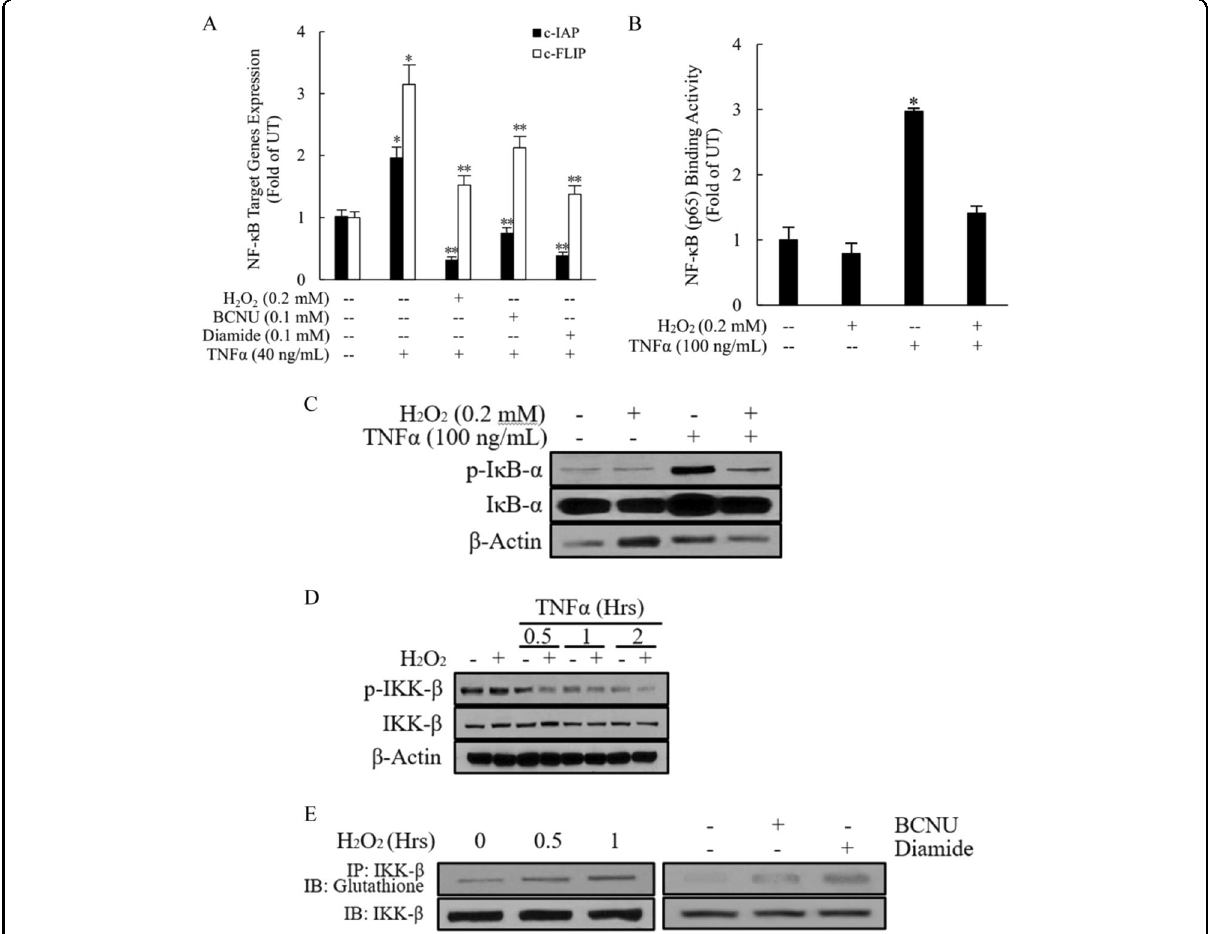
Fig. 6 GSSG suppresses TNF α -stimulated NF- κ B transactivation via induction of IKK- β glutathionylation. a H 2 O 2 , BCNU, or diamide pretreatment suppressed NF- κ B-mediated gene expression after TNF α stimulation. HepG2 cells were pretreated with H 2 O 2 , BCNU or diamide for 2 h before TNF α (40 ng/mL) addition. Total RNA was isolated, and NF- κ B-targeted gene expression was determined by real-time RT-PCR. All values are expressed as the mean ± SD from three or more independent studies. * p < 0.05, ** p < 0.01 versus TNF α -treated cells. b H 2 O 2 pretreatment suppresses TNF α -induced nuclear p65/DNA-binding activity. HepG2 cells were pretreated with H 2 O 2 (0.2 mM) for 2 h before TNF α (100 ng/mL) addition. Four hours later, nuclear fractions were isolated and subjected to ELISA for the measurement of p65/DNA-binding activities. All values are expressed as the mean ± SD from three or more independent studies. * p < 0.05 versus TNF α -treated cells. c H 2 O 2 pretreatment abolished the TNF α -stimulated increase in I κ B- α phosphorylation. HepG2 cells were pretreated with H 2 O 2 (0.2 mM) for 2 h before TNF α (100 ng/mL) stimulation, and cell lysates were collected 15 min after TNF α exposure for western blot analysis of phosphorylated I κ B- α . d H 2 O 2 pretreatment inhibited TNF α -stimulated IKK- β activation/phosphorylation. HepG2 cells were pretreated with H 2 O 2 for 2 h before TNF α (100 ng/mL) stimulation, and cell lysates were collected at the indicated time points for western blot analysis of the phosphorylated IKK- β levels. e H 2 O 2 , BCNU, or diamide pretreatment increased the IKK- β - SSG levels. HepG2 cells were treated with H 2 O 2 , BCNU, or diamide for 1 h, and cell lysates were collected and subjected to immunoprecipitation and western blot analysis for glutathionylated IKK- β . IB immunoblotting, IP